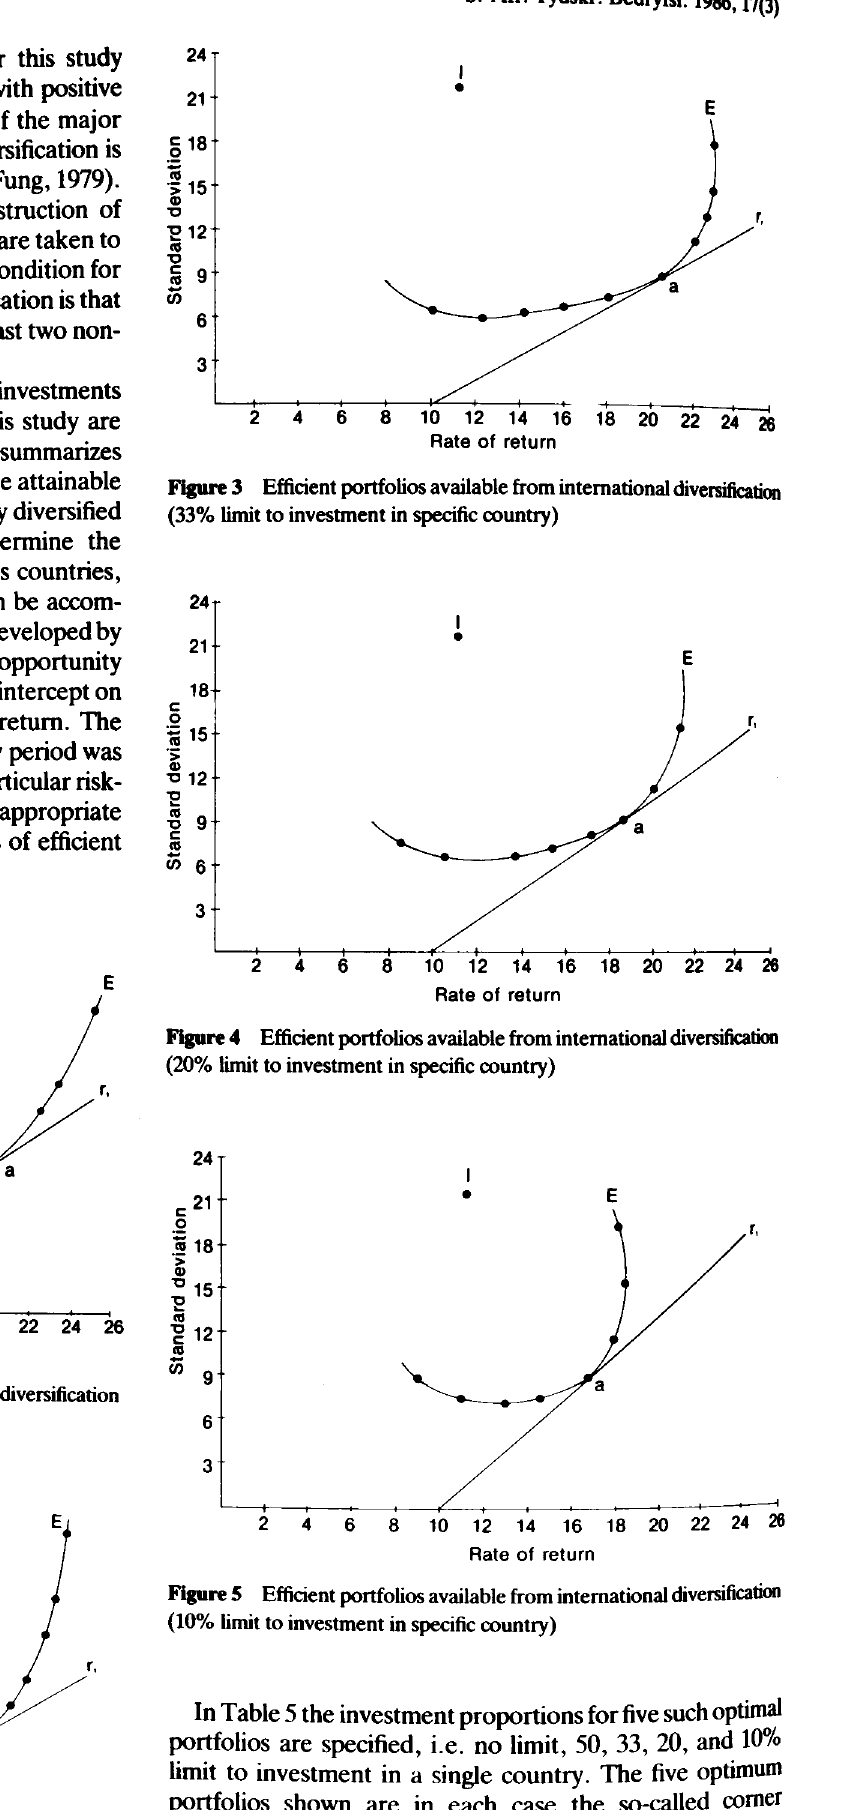
portfolios are specified, i.e. no limit, 50, 33, 20, and 10%